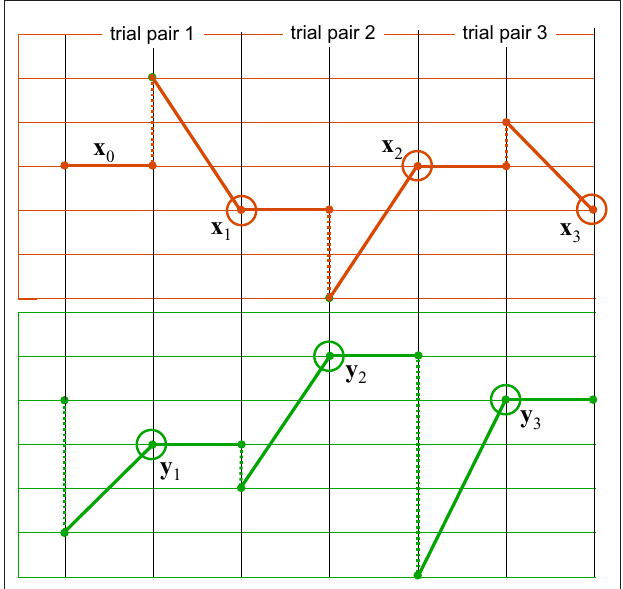
Figure 3 | A schematic representation of ping-pong adjustments. The top and bottom panels correspond to two observation areas, the vertical axes representing stimulus values (which need not, however, be unidimensional). Trials may or may not be separated by time intervals. A series of adjustments consists of many consecutive trial pairs. In the first trial of any trial pair, x remains fixed (solid horizontal lines, top panel) at the value established at the end of the previous trial pair; the value of stimulus y at the beginning of this first trial is randomly offset (dashed vertical lines, bottom) so that it generally does not match x , and the participant adjusts this value (oblique solid lines, bottom) until it seems to match x (the encircled points, bottom); in the second trial of the trial pair, y remains fixed (solid horizontal lines, bottom) at the value established at the end of the previous trial; the value of stimulus x at the beginning of this second trial is randomly offset (dashed vertical lines, top) so that it generally does not match y , and the participant adjusts this value (oblique solid lines, top) until it seems to match y (the encircled points, top). The stimuli x , x , x , … and y , y , y , … represented by the encircled points are referred to as 1 2 3 1 2 3 “balance points.” In this work we focus on the first-order